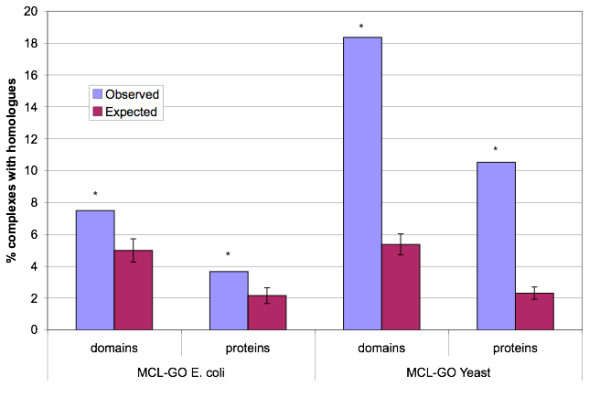
Percentage of MCL-GO complexes containing homologous pairs. Homologous pairs are defined here as either homologous domains shared between two proteins or proteins sharing a common domain architecture. All observed values were significantly larger than expected (p < 0.01).